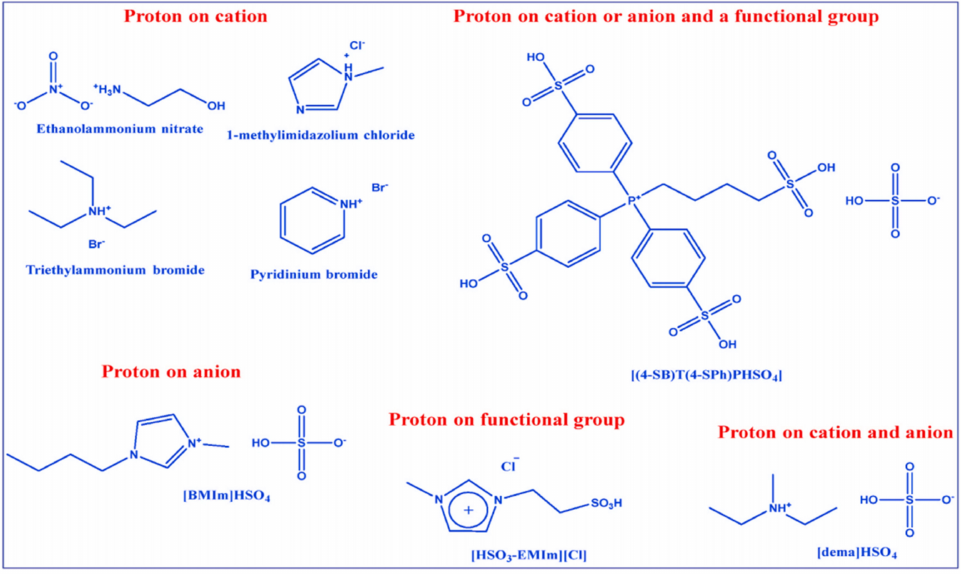
Figure 8. Types of protic ionic liquids